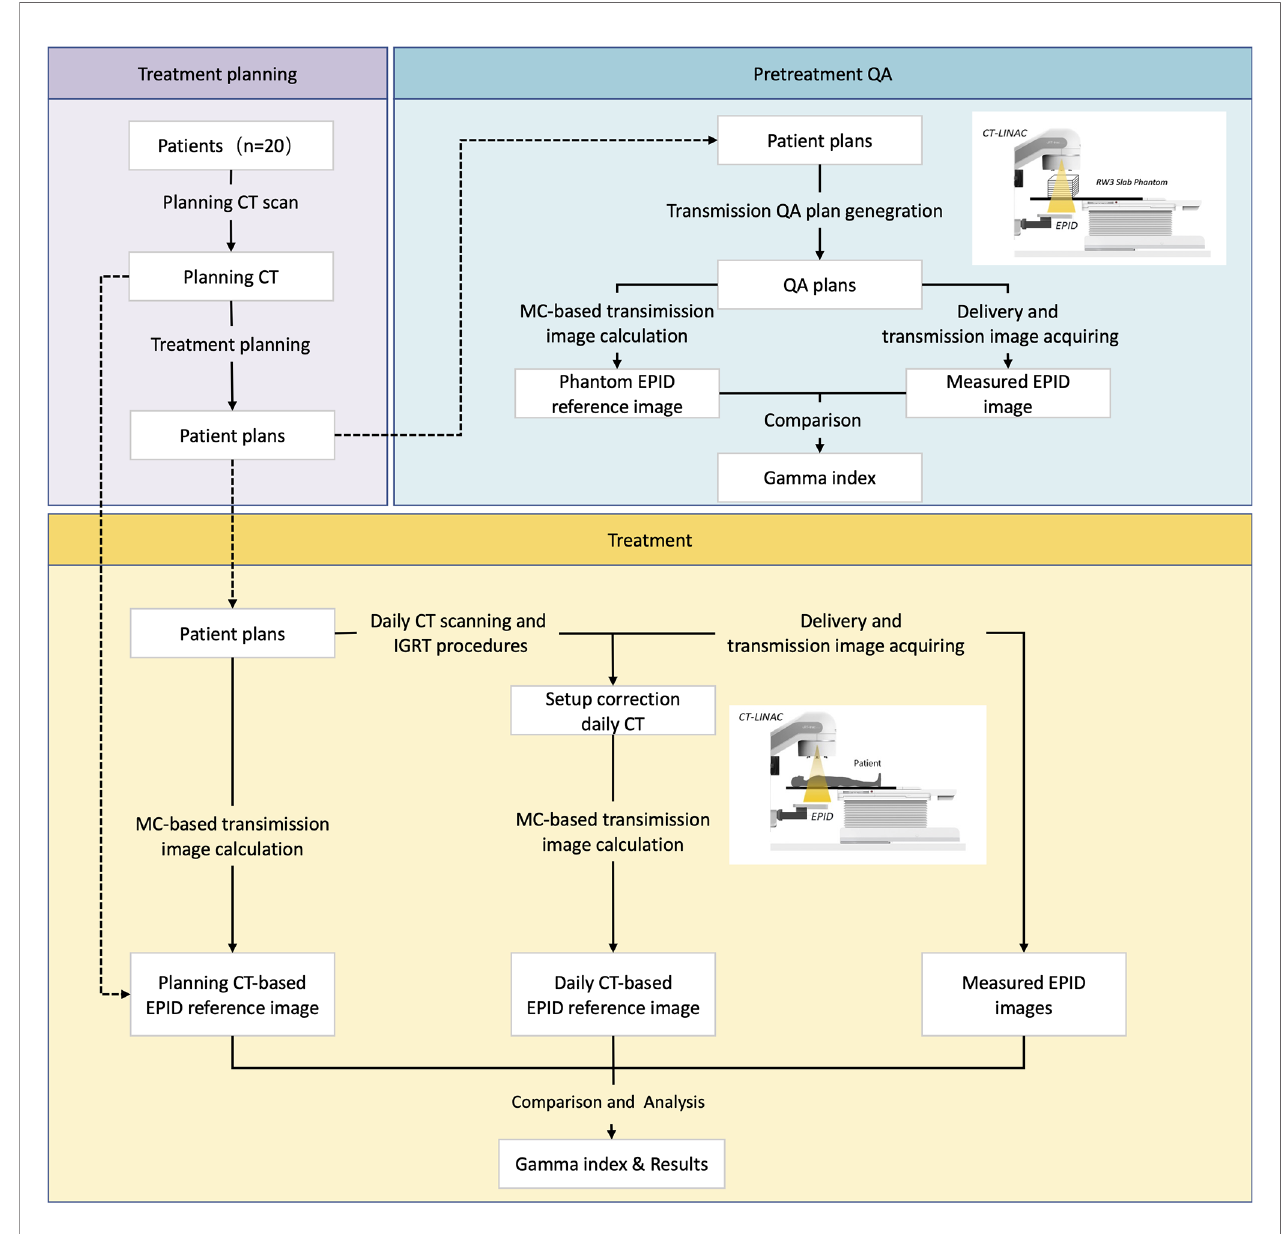
FIGURE 2 | The study work fl